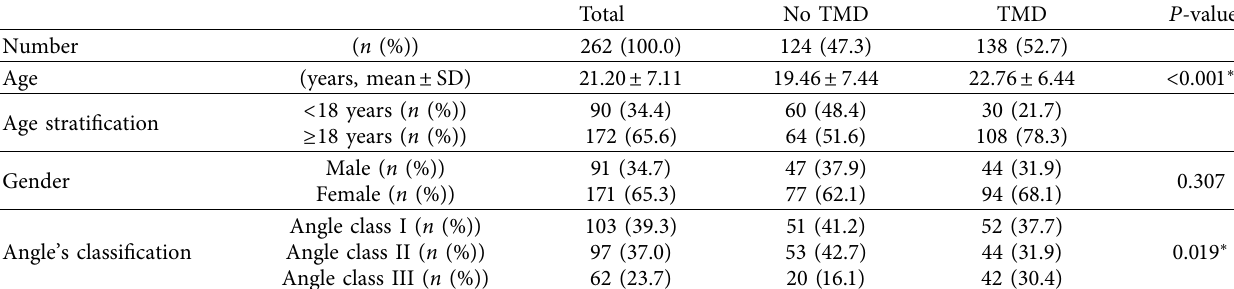
Table 1: Demographic and occlusal characteristics of patients with and without TMDs.